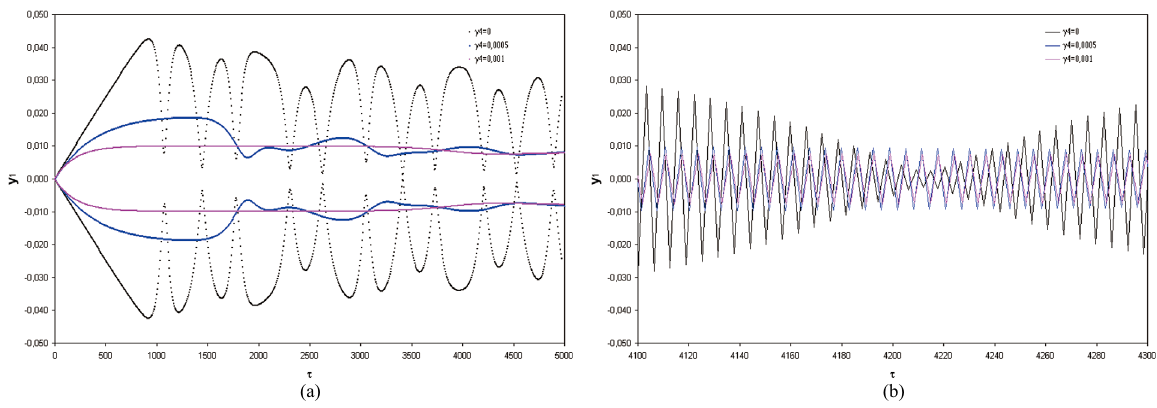
Fig. 2. Numerical solutions of y for different coefficients γ 4 and for a 1 = a 2 = 0.1; a 3 = 0.0001; γ 1 = 0.0001; γ 2 = γ 3 = 0; β 1 = 0.65; c =